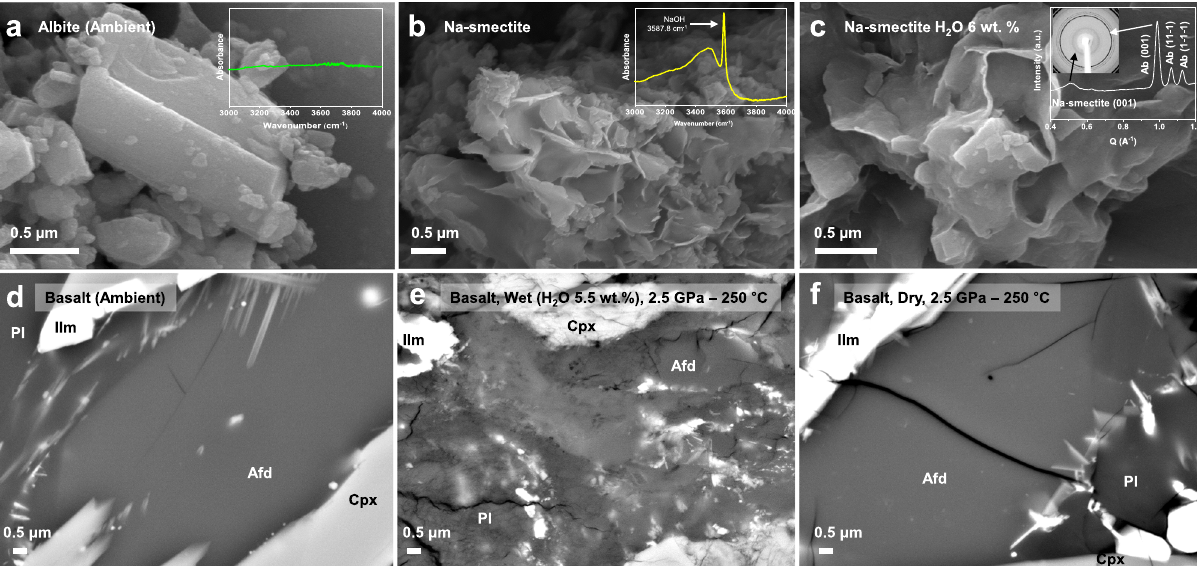
Fig. 3 SEM images of the original albite (basalt) and its recovered products after different PT treatments. Mid-IR spectra from respective samples are shown as inset images. a The original anhydrous albite is characterized by its prismatic crystal habits and featureless IR spectra (upper inset) whereas b the recovered product under 1:1 albite-to-water ratio shows the characteristic clay crystal habits and the IR band (upper inset) by NaOH at 3587.8 cm − 1 (ref. 27 ). The O – H stretching mode of the hydrated Na-smectite is also identi fi ed as a broad band at 3484 cm − 1 . c A representative SEM image and XRD pattern (upper inset) of the recovered product using 6 wt.% H 2 O from 2.4 GPa and 260 °C conditions (see Supplementary Fig. 2 for data using different water contents). d A representative SEM image of the original natural basalt (starting material). e A representative SEM image of the recovered